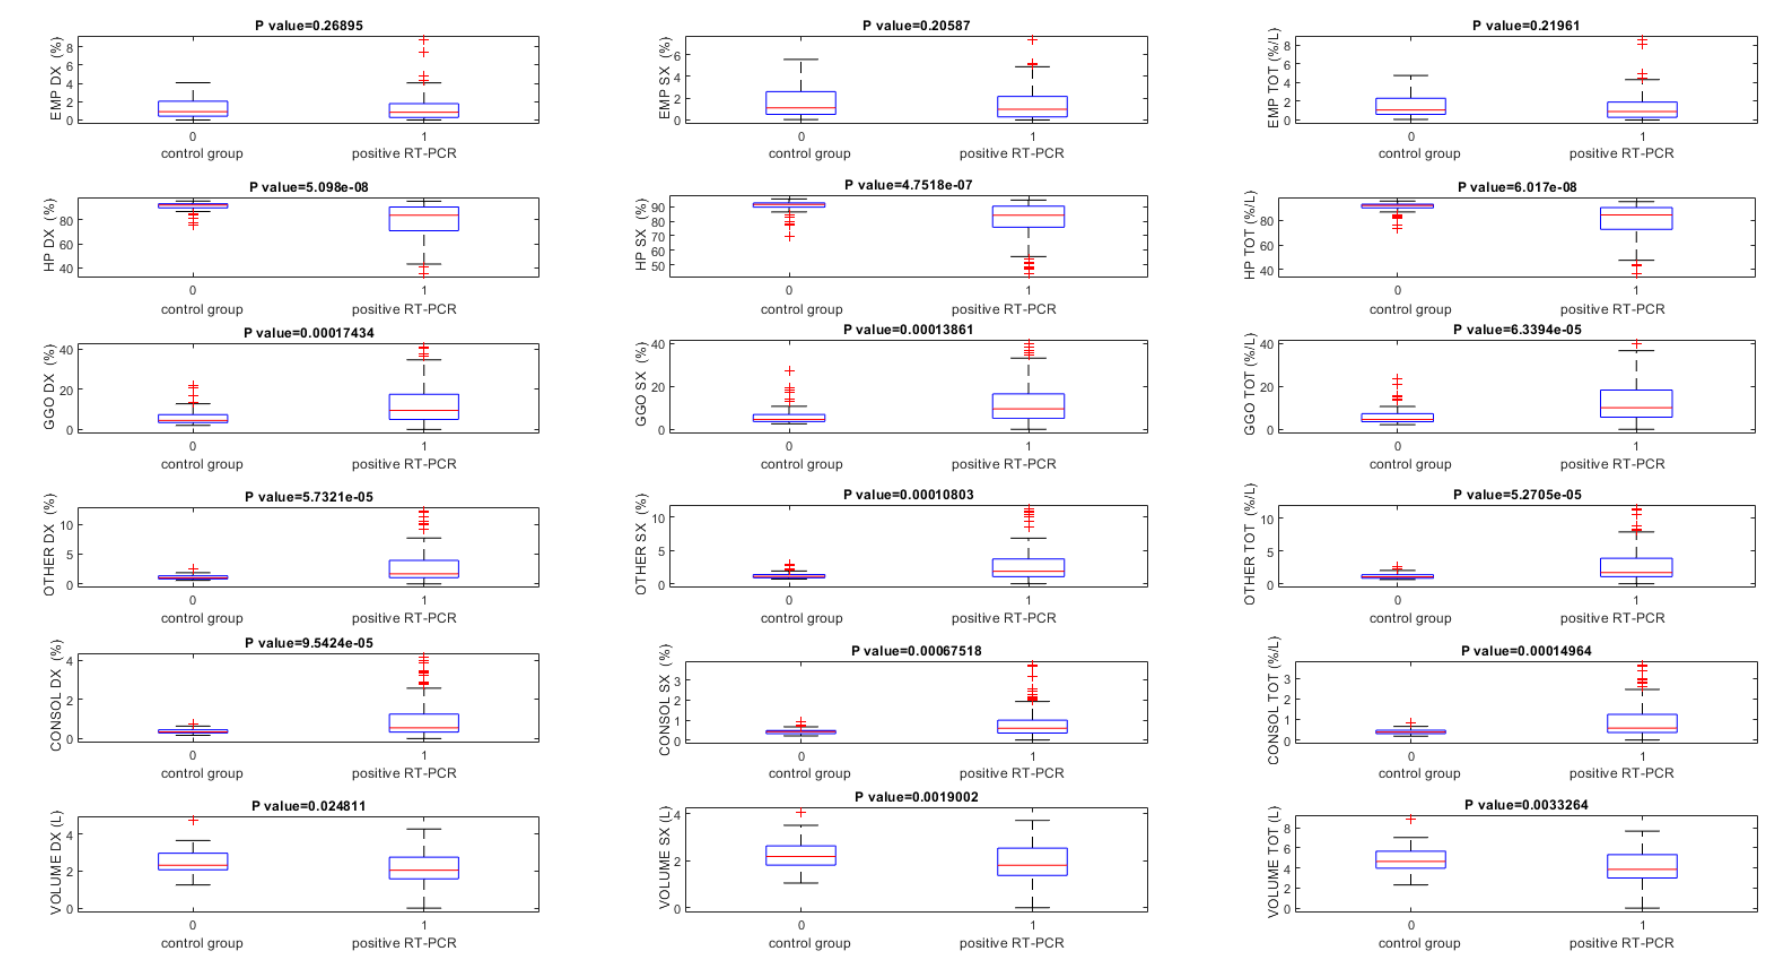
Figure 3. Boxplot of lung volumes quantified using the thoracic VCAR obtained on baseline CT scans. Note. EMP = emphysema; HP = health parenchyma; GGO = ground-glass opacity; CONSOL = consolidations.